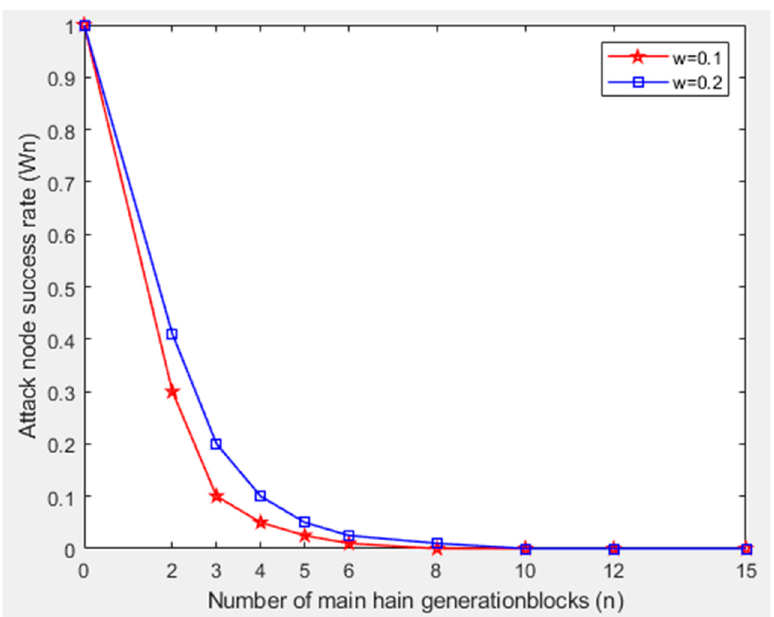
Figure 5. Probability of a successful attack.